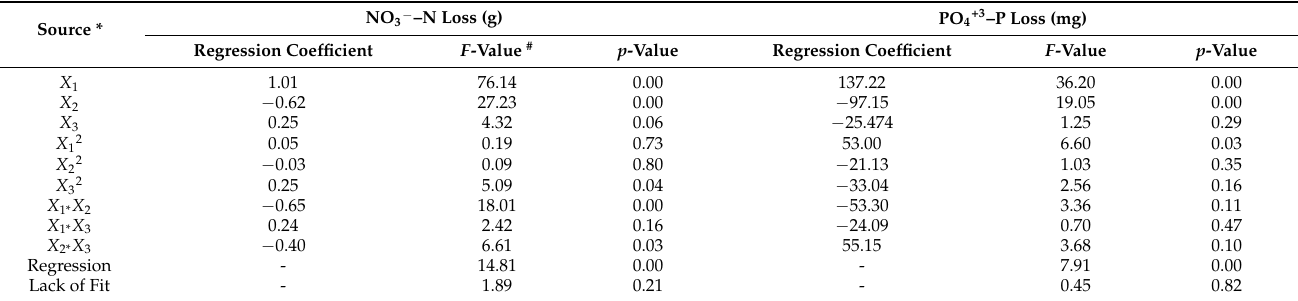
Table 3. The regression coefficient significance test for the second-order polynomial. Regression models of NO 3 − –N and PO 4+3 –P